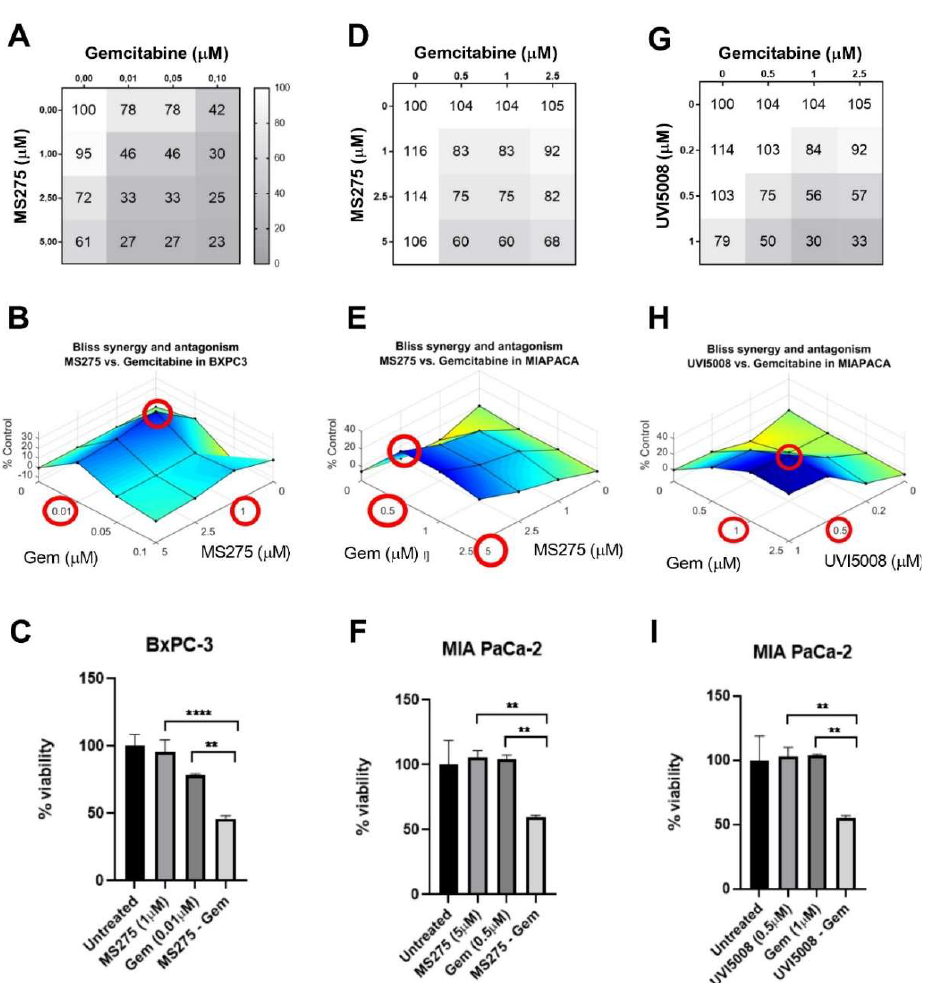
Figure 4. Synergistic antitumoral effect induced by gemcitabine in combination with MS275 in BxPC − 3 ( A – C ) and MIA PaCa − 2 cells ( D – F ), or with UVI5008 in MIA PaCa − 2 cells ( G – I ). Cell viability matrix ( A , D , G ); (bliss synergy graphs B , E , H ). Red circles: highest synergy score and the associated concentrations; ( C , F , I ). Cell viability of BxPC − 3 and MIA PaCa − 2 cells with the combinations and the individual drugs at the concentrations that showed the highest synergistic effect. Statistically significant differences compared to untreated cells were represented as: ** p ≤ 0.01 and **** p ≤ 0.0001.